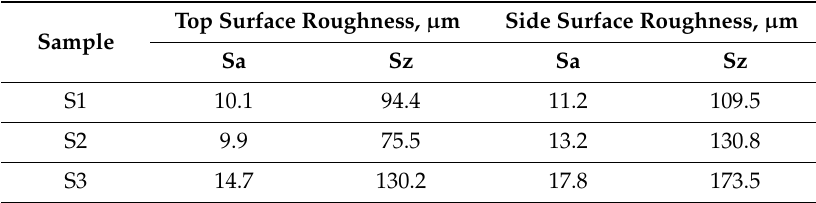
Table 5. The roughness of the top and side surfaces of the printed samples.